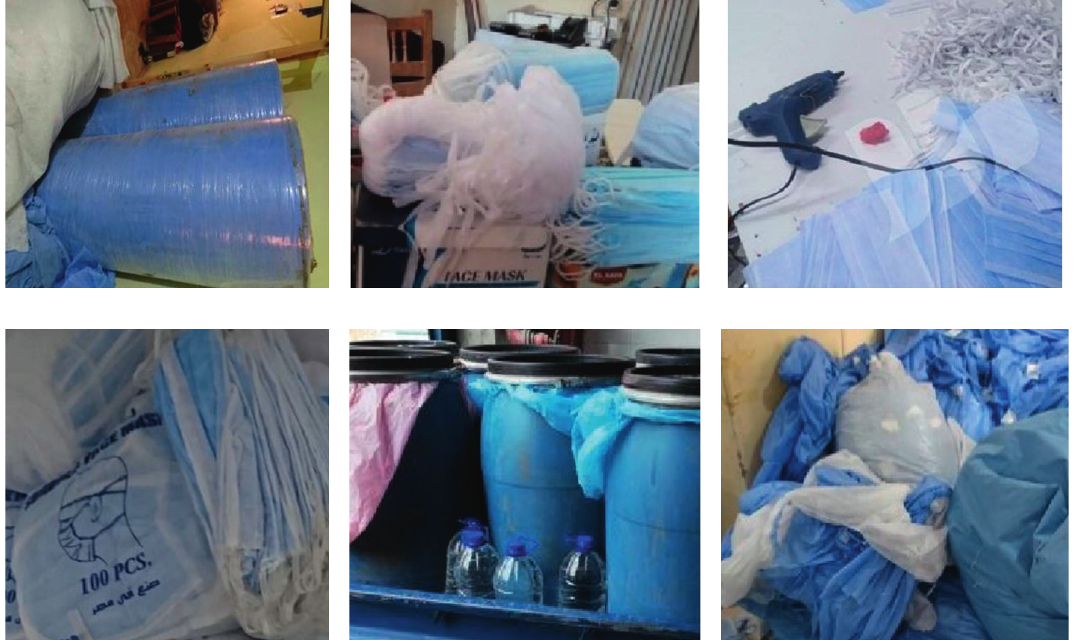
Figure 19: Medical supplies not conforming to the specifications of quality [25].